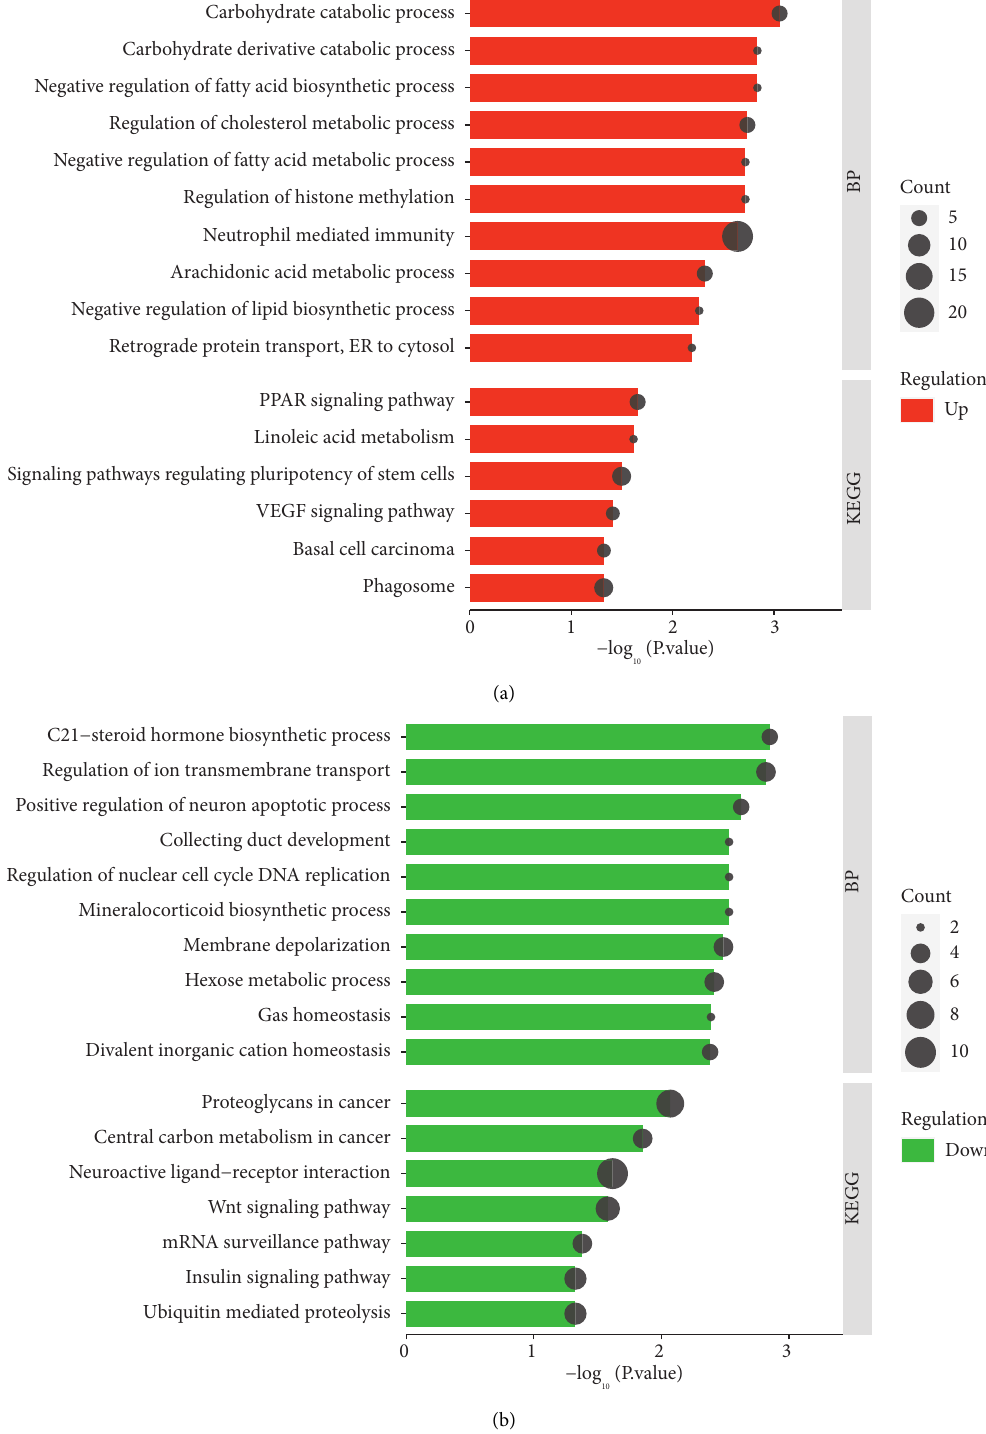
Figure 2: GO functional and KEGG pathway analysis of DEGs. (a) BP and KEGG enrichment analysis of upregulated DEGs. (b) BP and KEGG enrichment analysis of downregulated DEGs. The bar stands for the size of the P value, the longer the bar, the smaller the P value; the dot stands for the number of genes, the larger the dot, the more the number of protective function on the human body. White blood cells Generally, peripheral blood cells can be divided into are deformed and pass through the capillary wall to focus on three types: white blood cells, red blood cells, and platelets the part where the bacteria invade, surround, and swallow [13]. Among them, white blood cells have a paramount